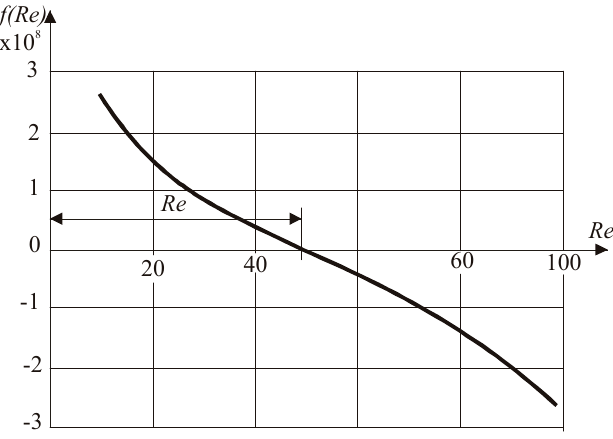
Figure 3. Example of the dependence of the function f(Re) on the Reynolds number (Re) for.